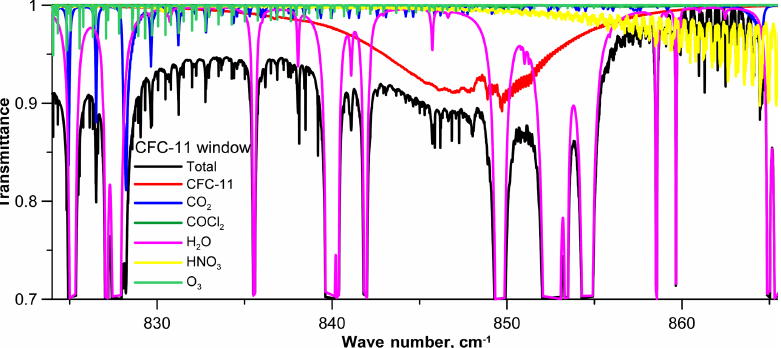
Figure A1. Absorption by various gases in the spectral region of the CFC-11 absorption band (7 November 2017, 09:57UTC; SZA is 76 ◦ ).